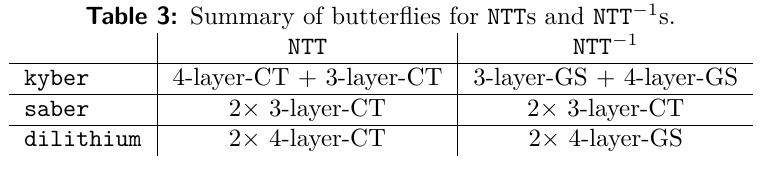
Table 3: Summary of butterflies for NTT s and NTT − 1